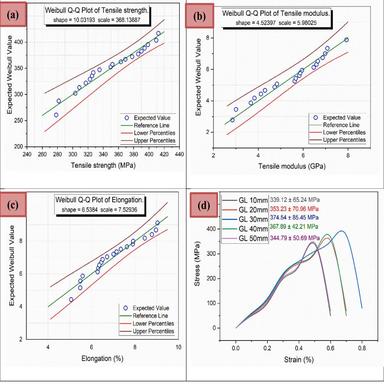
Weibull Q-Q plot for (a) tensile strength; (b) tensile modulus; and (c) elongation; (d) stress-strain.